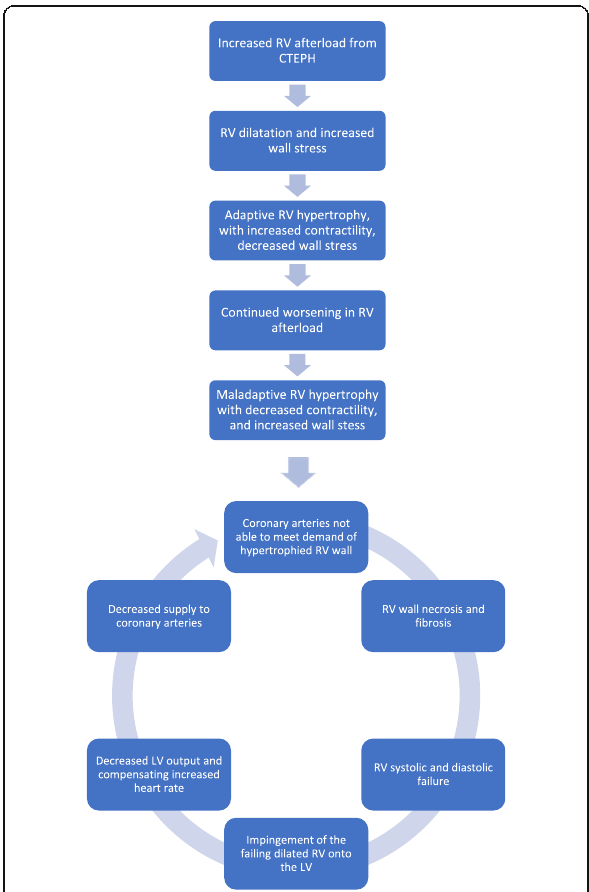
Fig. 15 The events of CTEPH and progressive right heart failure. Diagram demonstrates the events leading to the spiral in CTEPH that leads to right heart failure and ultimately death if no effective intervention is performed